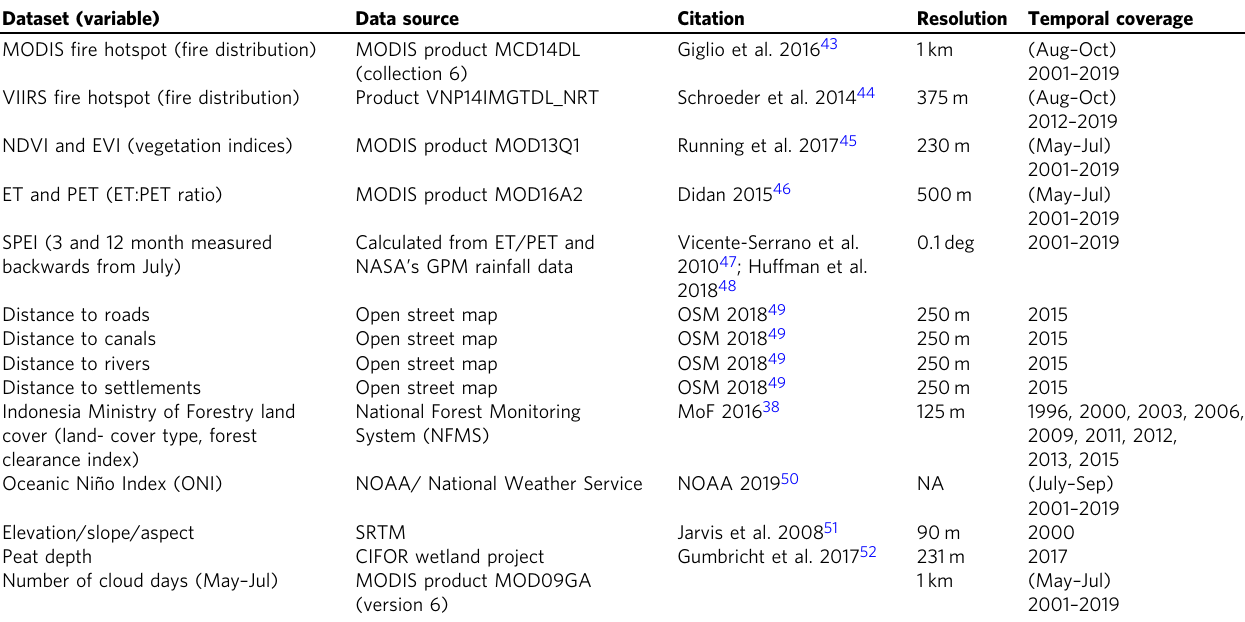
Table 1 Model input data sources, citation, original resolution, and date